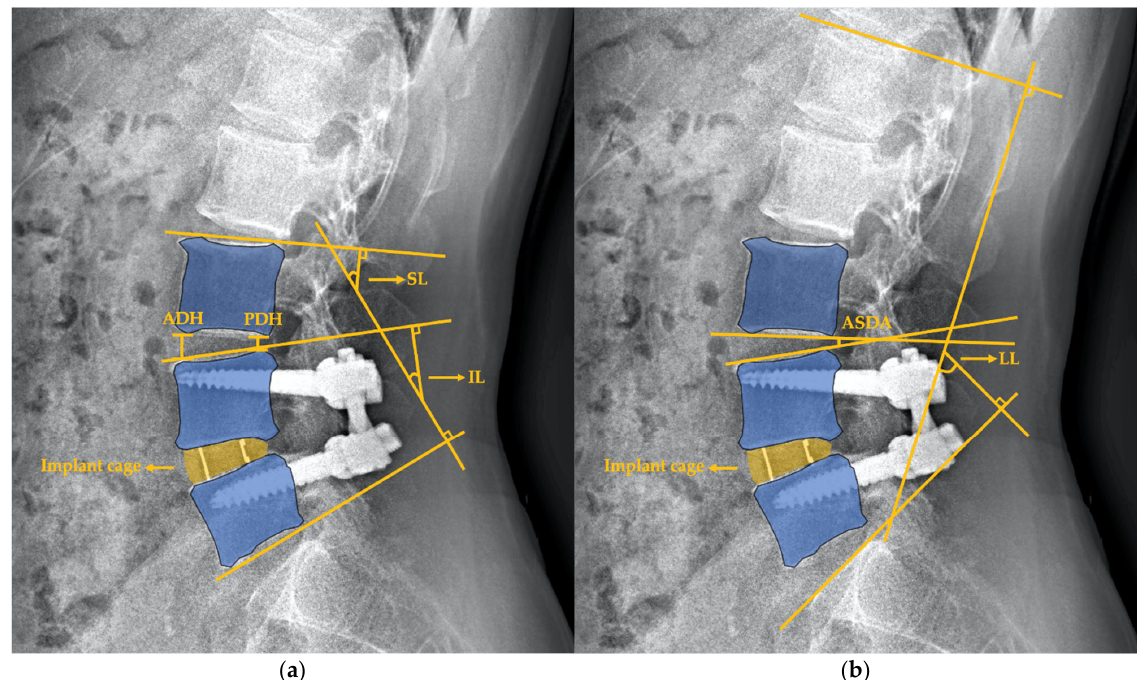
Figure 1. Schematic of radiographic measurement in morphological changes in adjacent segments. These figures showed L4/5 OLIF in situ. ( a ) Index lordosis (IL) and segmental lordosis (SL), anterior disc height (ADH), and posterior disc height (PDH) ( b ) Adjacent segment disc angle (ASDA) and lumbar lordosis (LL).